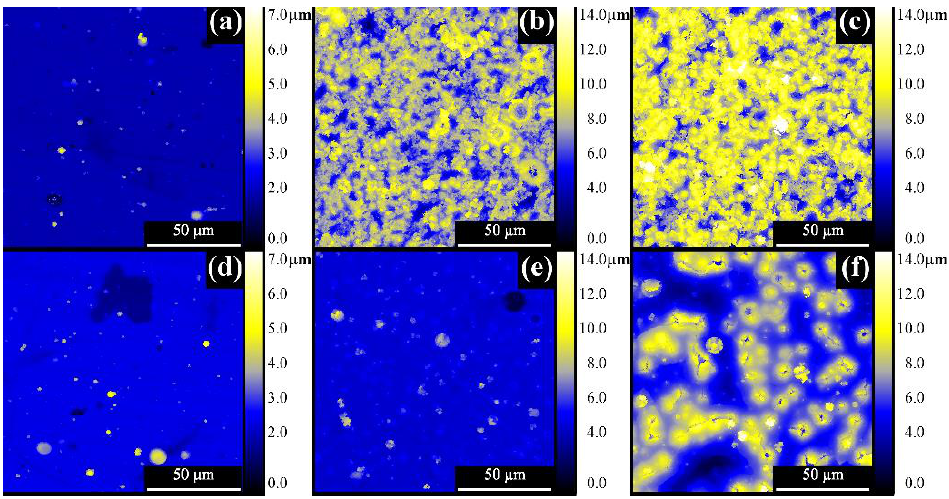
Figure 3. The multilayer coating surfaces oxidized at 300 °C ( a , d ), 600 °C ( b , e ) and 700 °C ( c , f ) .